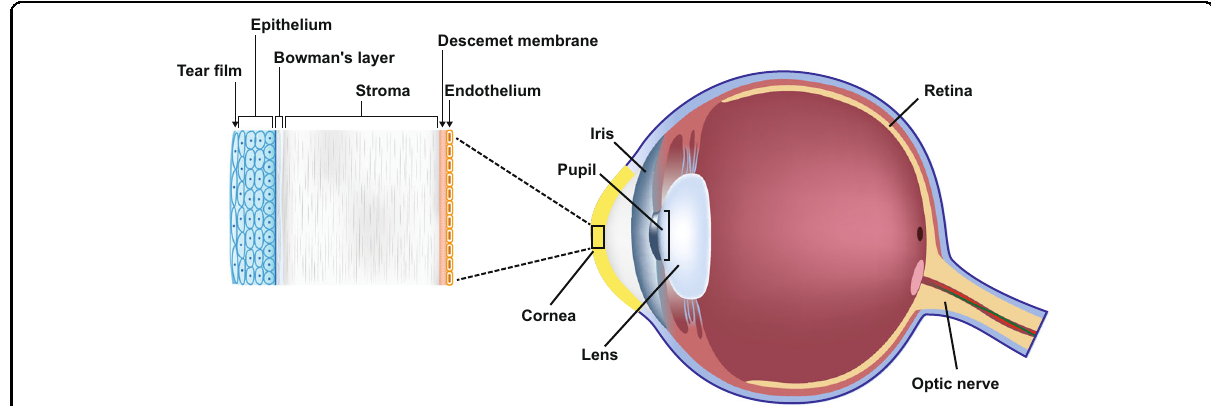
Fig. 1 Anatomy of the eye, with focus on the cornea. AE adverse event, belamaf belantamab mafodotin. Belamaf-associated AEs were reported in the corneal epithelium, which is the outermost layer of the eye 7